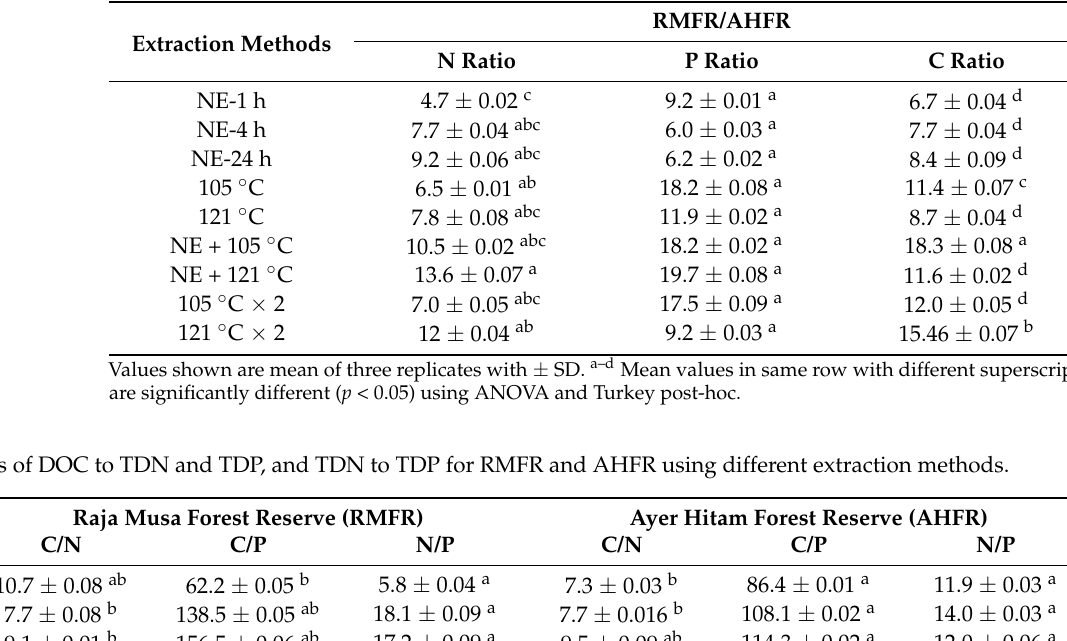
Table 1. Ratios of concentrations of TDN, TDP, and DOC in Raja Musa Forest Reserve (RMFR) to Ayer Hitam. Forest Reserve (AHFR).